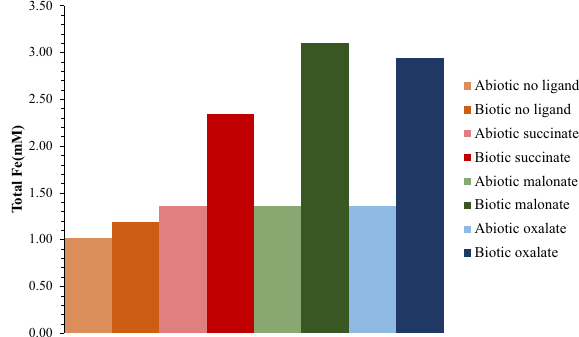
Fig. 5 Total (dissolved and solid phase) iron at the end of experiments with oxidized carbon steel and 50 mM dicarbox- ylates. Experiments were carried out under anoxic and dark conditions, at circumneutral pH, and 30